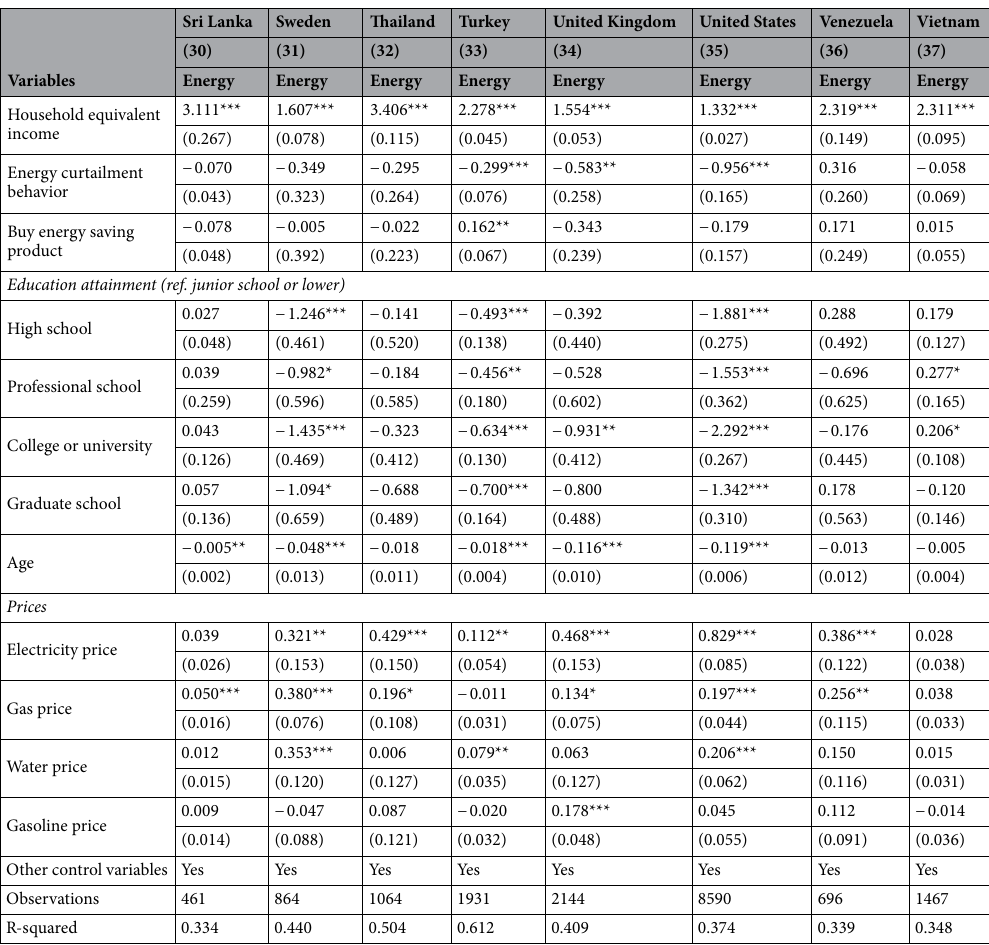
Table 7. Household socioeconomic and demographic determinants of household energy consumption expenditure IV. Standard errors in parentheses. *** p < 0.01, ** p < 0.05, * p < 0.1. Other control variables include occupational status, household status, number of children, and gender